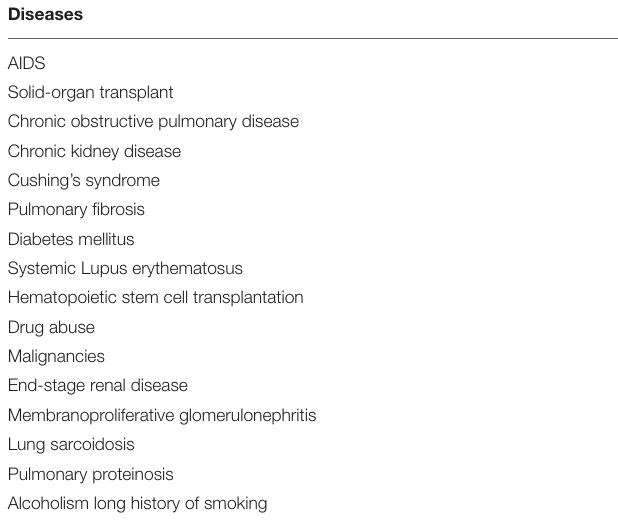
TABLE 1 | Some risk factors for